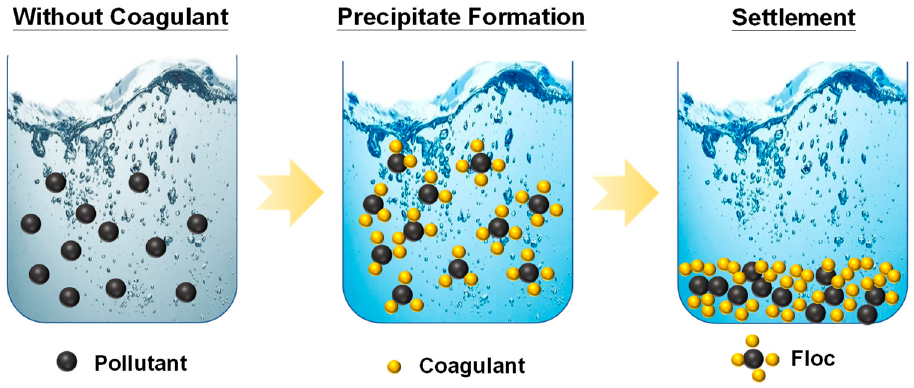
Figure 3. Principles of chemical coagulation used for removing colloidal pollutants in wastewater.